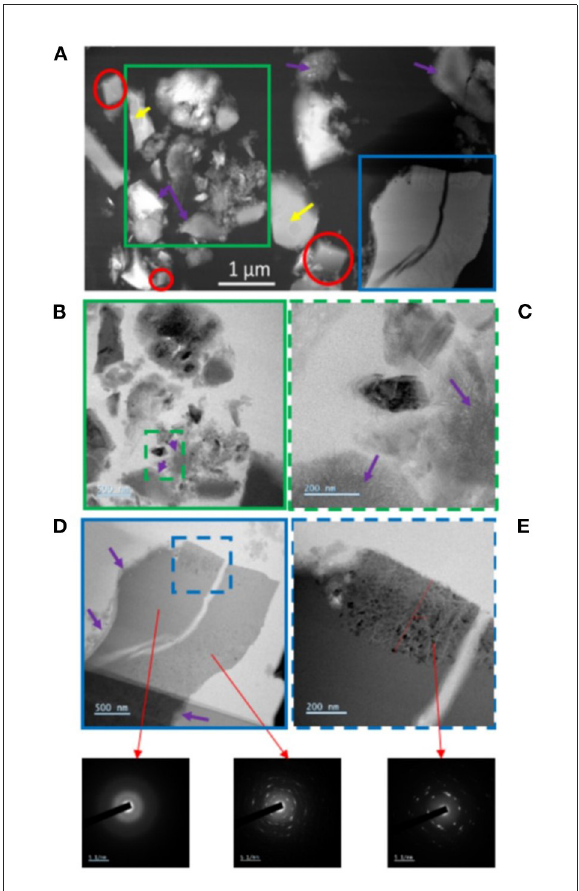
FIGURE11 TEM micrograph of a FIB thin section of carbonation products obtained in AC mode after 15 min: (A) overview STEM image, (B,C) zooming of submicron particles, (D,E) zooming of a residual slag particle of a few microns and diffraction images of different characteristic zones (red circles: carbonates, yellow arrows: amorphous silica rich in aluminum, purple arrows: